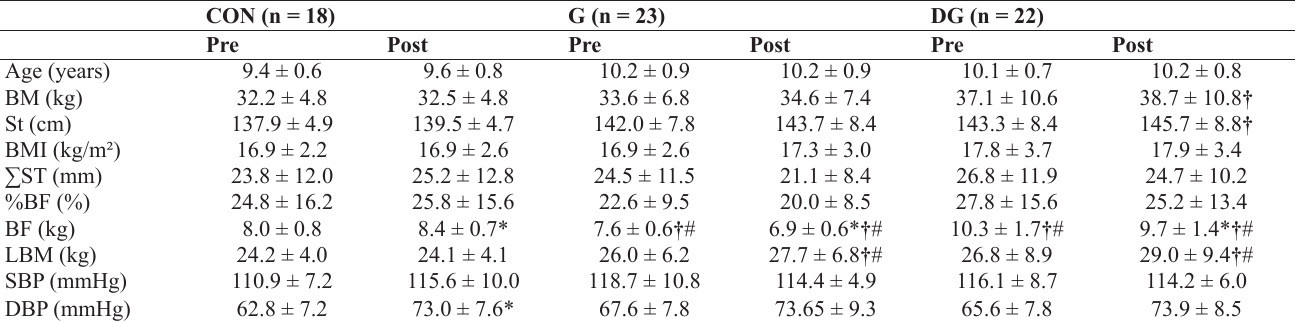
Table 1. Mean (±SD) values of sample characteristics and anthropometric, body composition, and blood pressure data pre- and post-intervention (n = 63). CON (n = 18) G (n = 23) DG (n = 22) Pre Post Pre Post